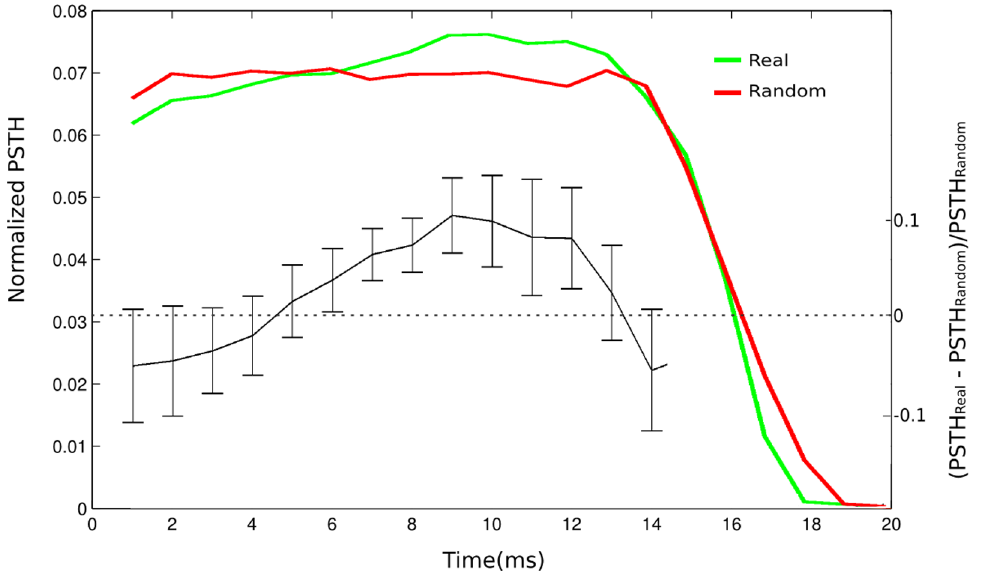
Figure 10. Normalized Post Stimulus Time Histograms (PSTH). The PSTH for stimuli from a random distribution of IPIs (red) presents a flat shape up to the limit of the mean IPI ( , 17 ms), whereas the PSTH for a real distribution of stimuli IPIs presents a peak probability of approximately 10 ms. The PSTH change (black) when the random stimuli distribution is replaced by real stimuli shows an average decrease of probability ( , 5%) in the 0–5 ms-range and the probability in the range of 6–12 ms increases , 10%. Error bars indicate the standard deviation, obtained from experiments with 8 fish. The changes correspond to 3% to 5% of the total number of EODs and is evidence that fish discriminate between real and random stimuli distributions (ANOVA, p , 0.002).